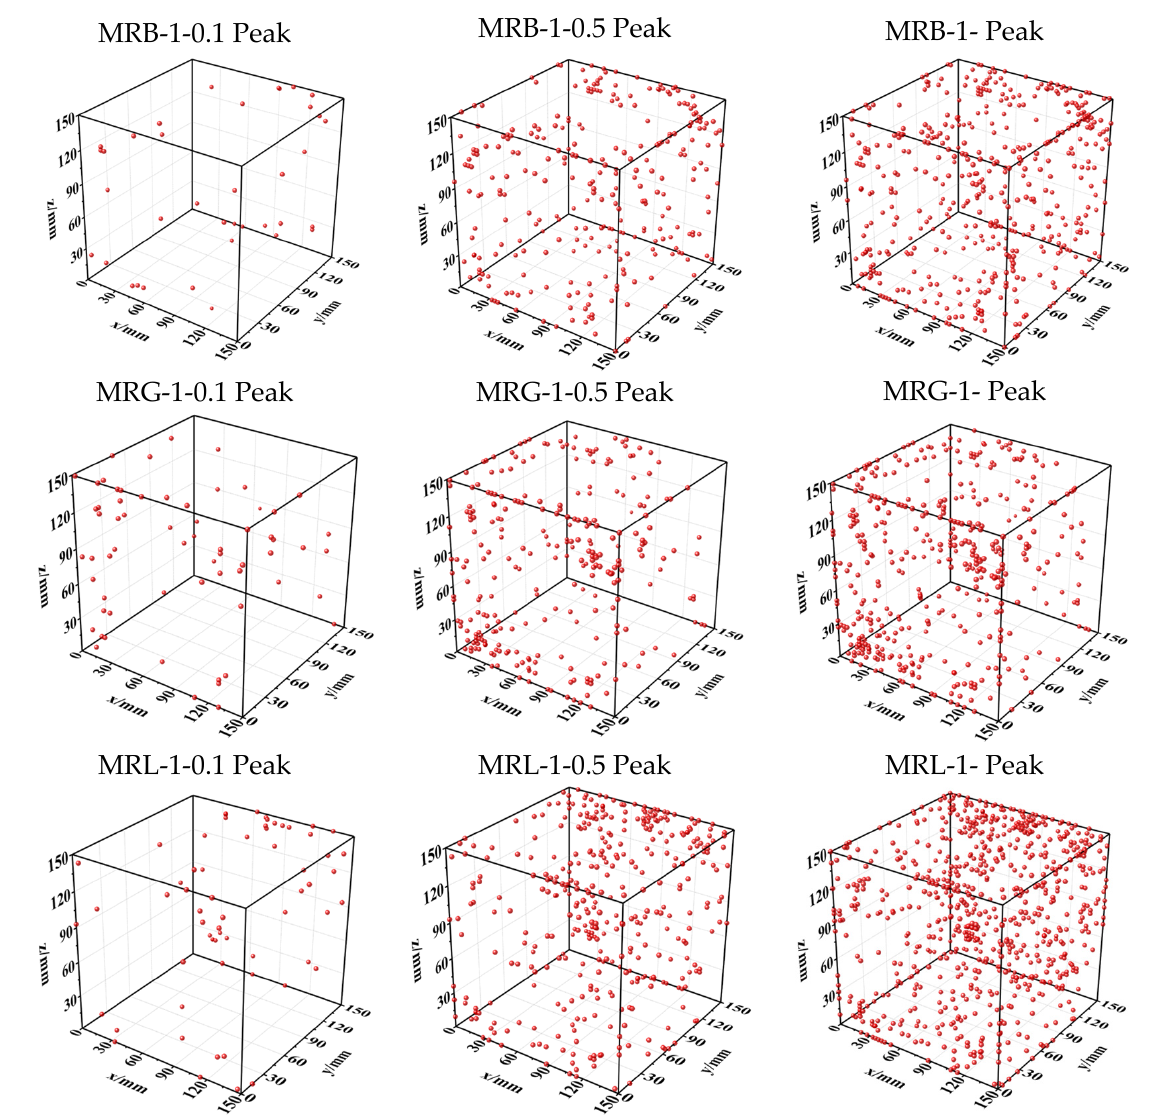
Figure 14. Location of the AE signal